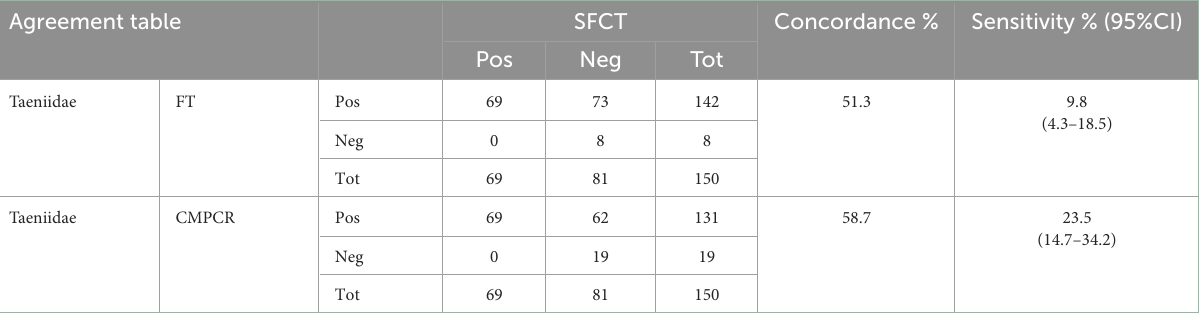
TABLE 2 Agreement table between results at SFCT (scraping, filtration and counting technique) and FT (zinc chloride floatation) and CMPCR (multiplex PCR) for Taeniidae. Agreement table